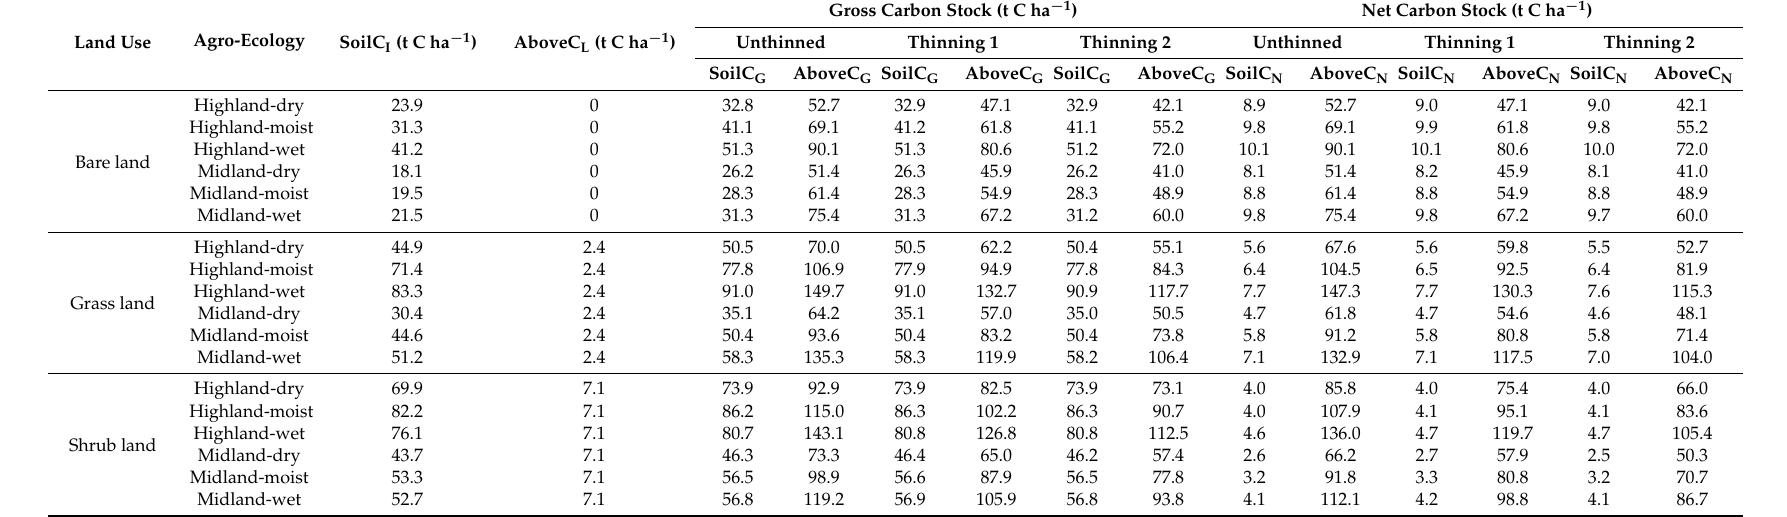
Table 3. Model predicted carbon sequestered through reforestation after 100 years for different current land uses, in different agro-ecological zones and under different managements. Initial soil carbon (SoilC I ) and aboveground carbon (AboveC L ) are obtained as described in Table 1. Net carbon stock (SoilC N , AboveC N ) is the difference between gross carbon stock (SoilC G , AboveC G ) and the corresponding initial carbon stock (SoilC I and AboveC L